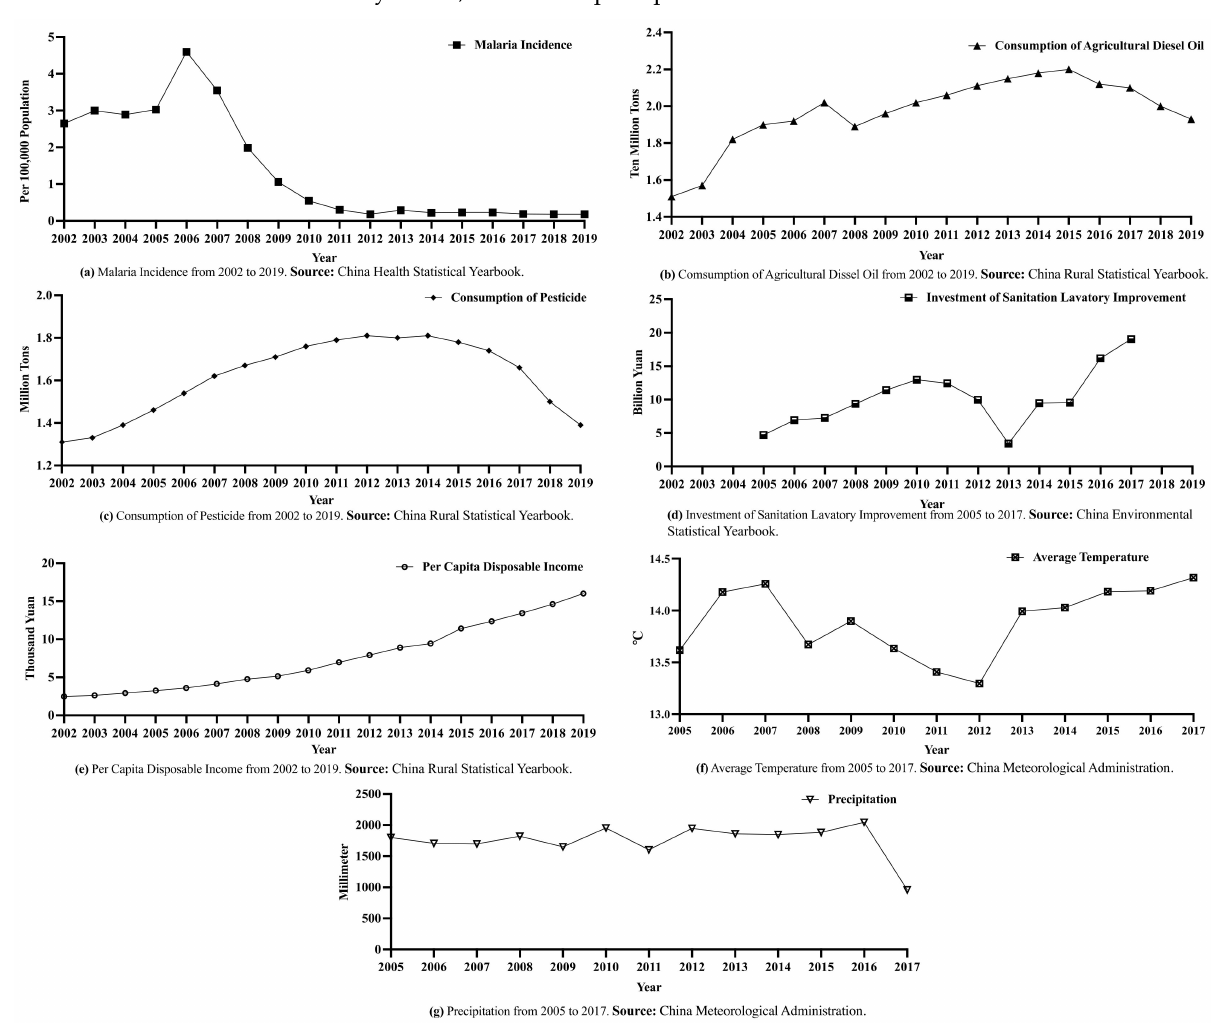
Figure 4. Malaria incidence with agricultural use of diesel and pesticides, investment in lavatory sani- tation improvement, per capita disposable income of farmers, average temperature, and